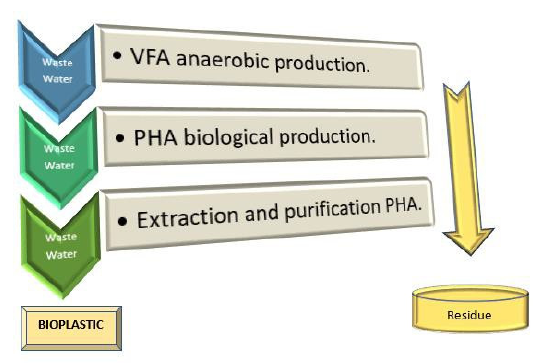
Figure 2. Bioplastic